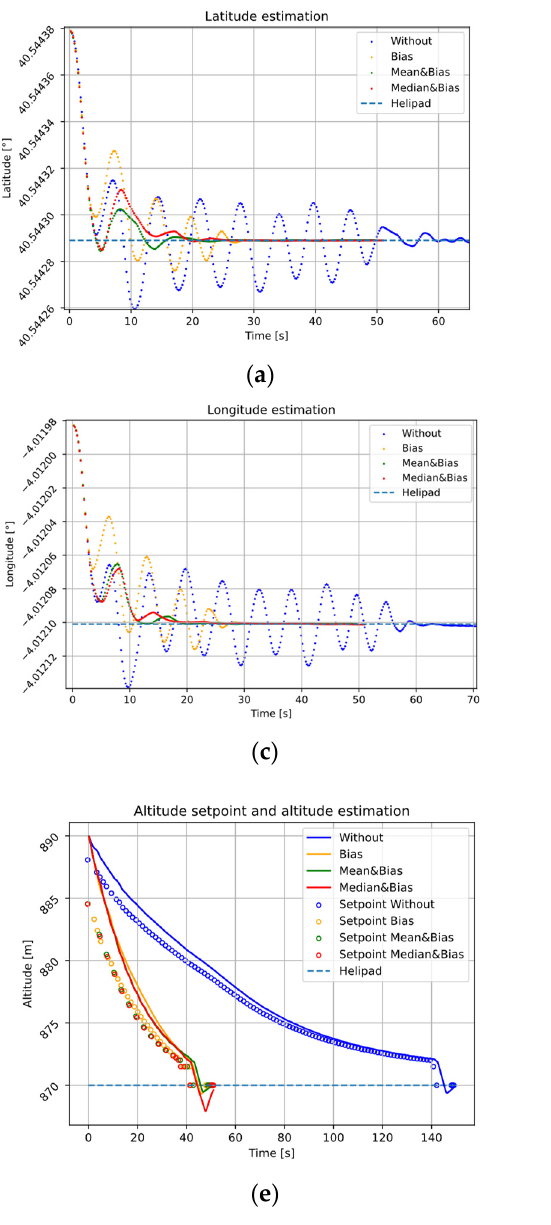
Figure 15. Time evolution of the latitude, longitude, and altitude of four flights with different correction modes in the landing phase: ( a , b ) latitude, ( c , d ) longitude, and ( e , f ) altitude. First column ( a , c , e ) exponential decrease, second column ( b , d , f ) linear decrease.